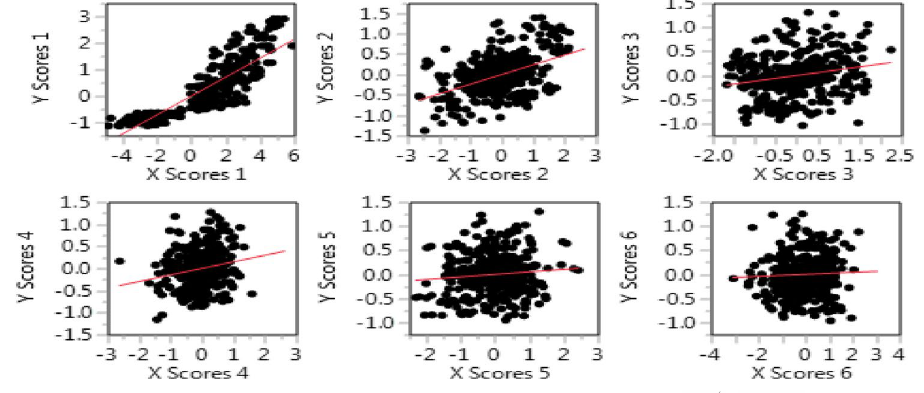
Fig. 7 Scores plots for volume loss model